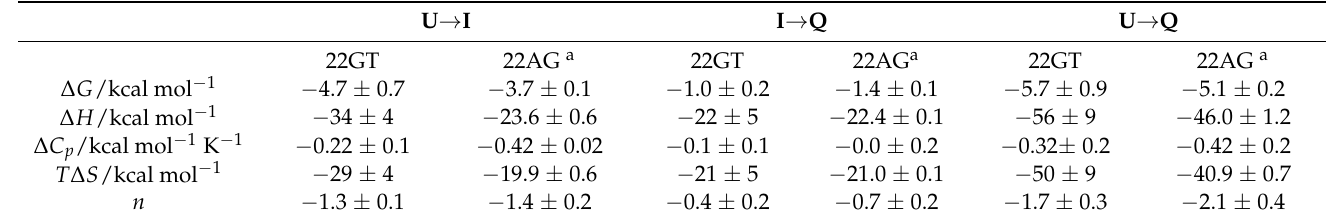
Table 1. Standard thermodynamic parameters of 22GT and 22AG folding ( T = 25 ◦ C, [K + ] = 100 mM) and the corresponding no. of exchanged K + ions ( n